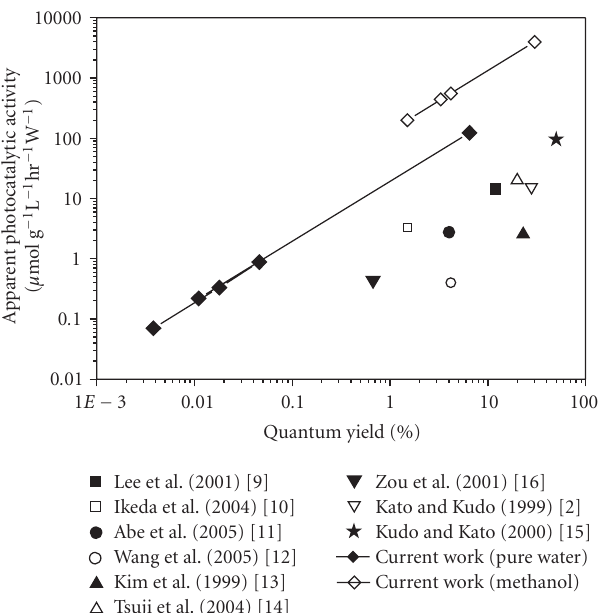
Figure 12: Evaluation of photocatalyst performance based on quantum yield and apparent photocatalytic activity.